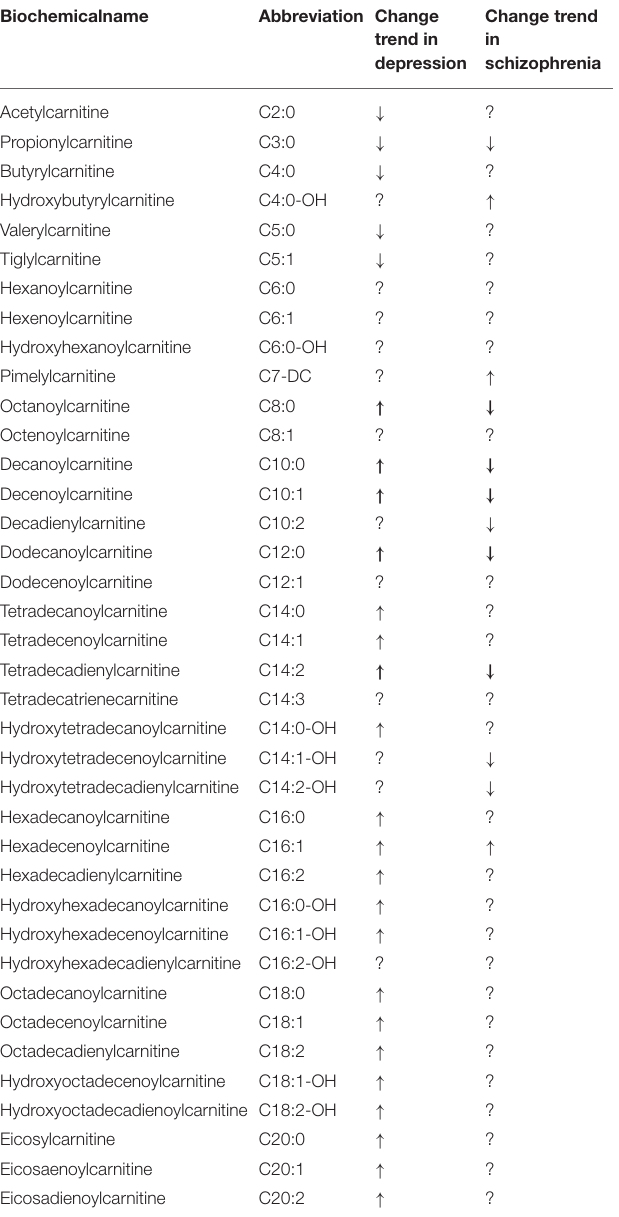
and activated a network with mGlu2 receptors to prime enhanced glutamate homeostasis that promotes both pro-resilient and antidepressant-like responses Change trend in trend in schizophrenia depression